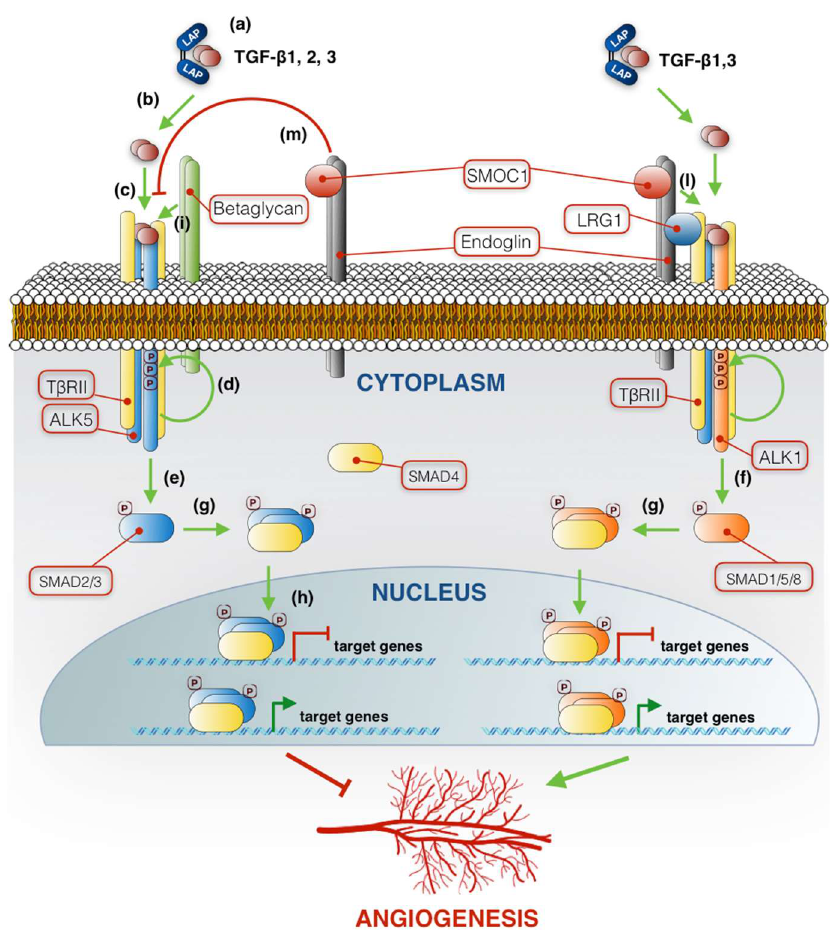
Figure 1. Schematic representation summarizing the transforming growth factors-beta (TGF-β) receptor complexes and signaling pathway in endothelial cells. The green arrowhead lines represent positive crosstalk interactions and steps. Red flat-ended lines indicate inhibition. In the nucleus, the green arrowhead and red flat-ended lines on the DNA represent activation and inhibition of gene expression, respectively. ( a ) LAP-TGF-β latent complex. ( b ) Release of TGF-β from the complex with LAP. ( c ) TGF-β binding to the heterotetrameric receptor complex. ( d ) TβRII phosphorylation of type I receptor ALK5. ( e ) SMAD2/3 phosphorylation by ALK5. ( f ) SMAD1/5/8 phosphorylation by ALK1. ( g ) Dimerization of R-SMADs with SMAD4. ( h ) Translocation of the R-SMAD/SMAD4 complex into the nucleus and binding to regulatory sequences. See text for details.